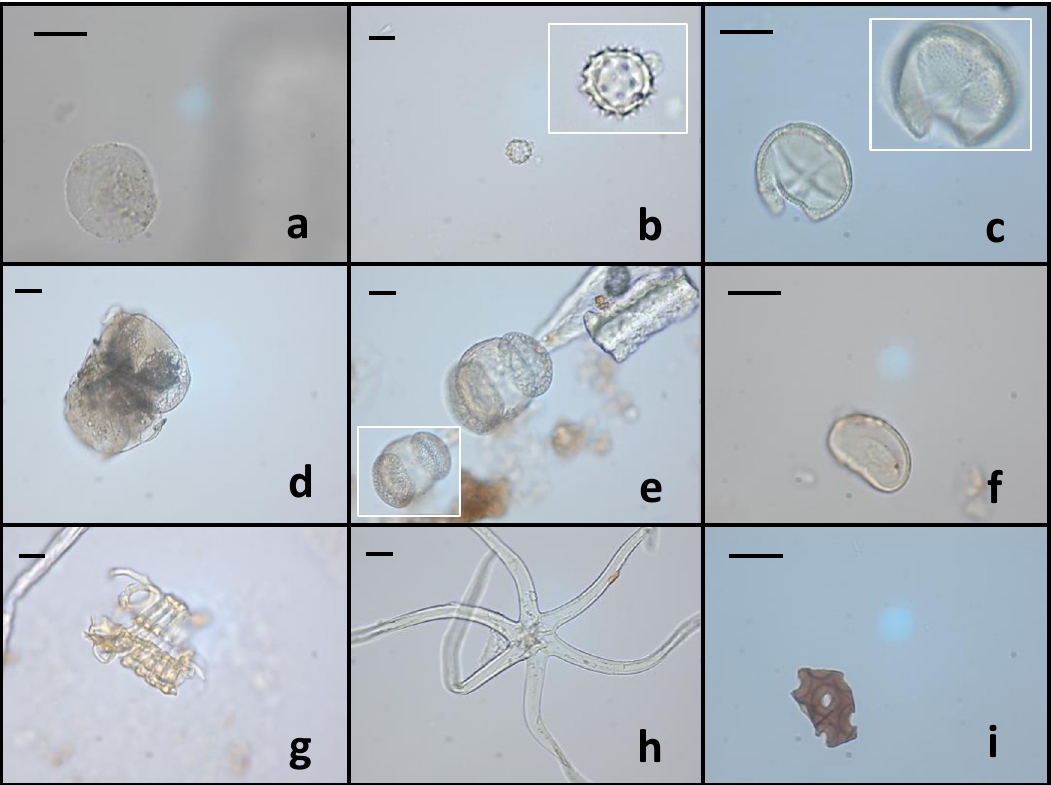
Fig. 3 Plant microparticles from animal calculi. Representative images obtained by light microscopy analysis were shown. a Triticeae starch. b Undifferentiated Asteroideae pollen. c Undifferentiated Fabaceae pollen, the upper focus is reported in the white box. d Lump of Pinaceae pollen. e Pinaceae pollen, adhering fl ecks of calculus can also be seen, and another focus of this microremain is in the white square. f Monolete spore. g Spiral vessels. h Stellate trichome. i Tracheid fragment from conifer wood. The scale bar indicates 15 µ